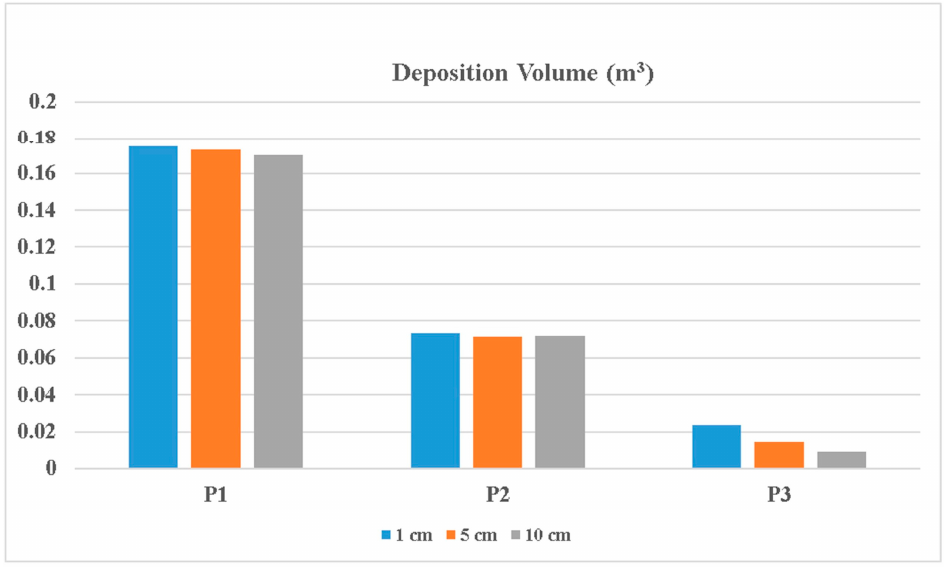
Figure 14. Total erosion volume change assessment based on CMA analysis after three wave application periods.